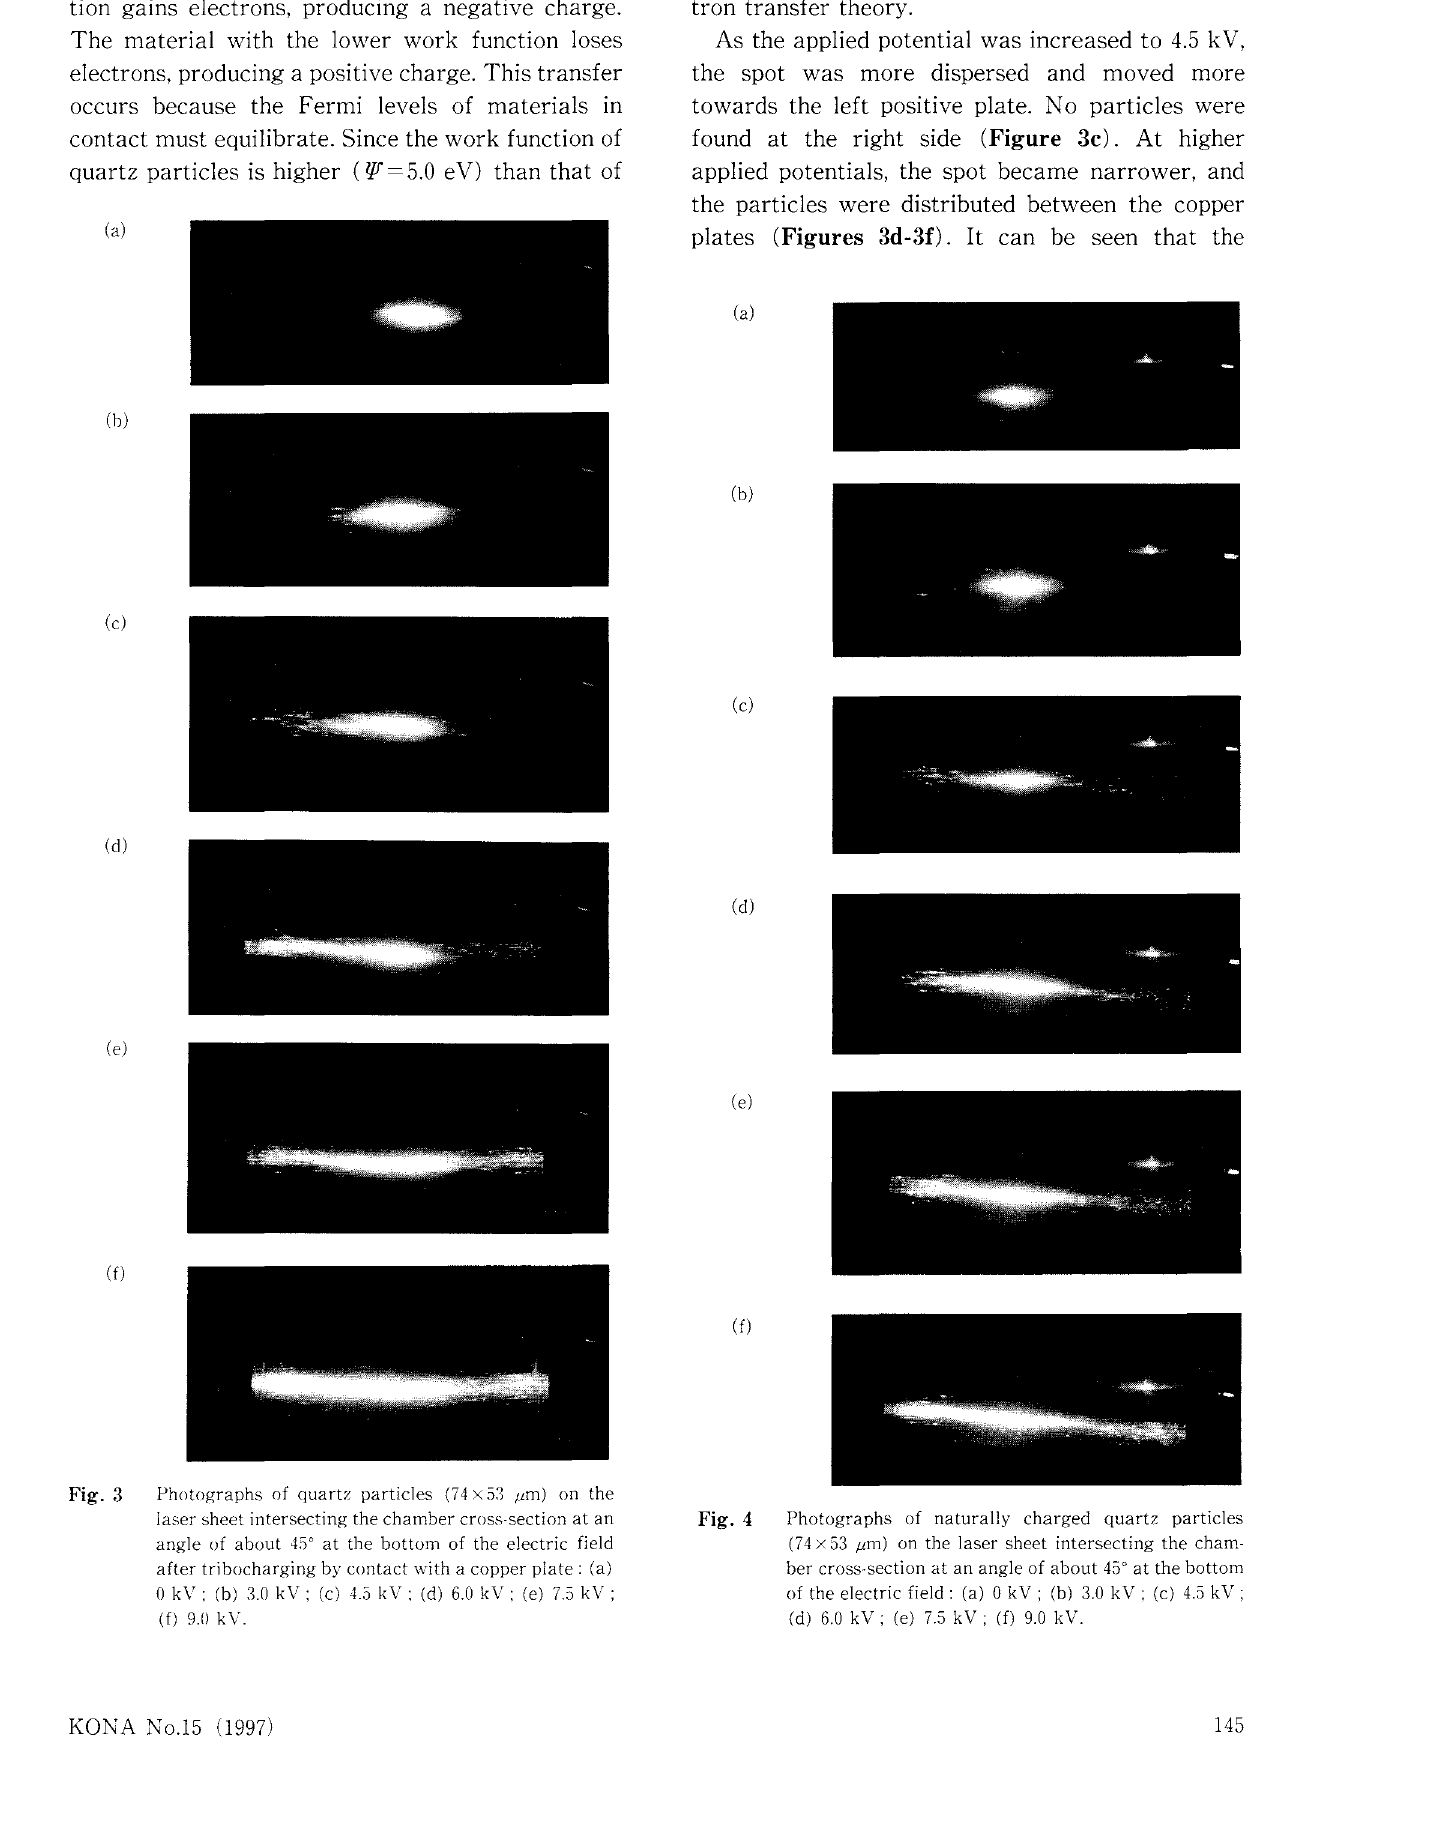
Fig. 3 Photographs of quartz particles (74 x5:l 11m) on the laser sheet intersecting the chamber cross-section at an angle of about 45° at the bottom of the electric field after tribocharging by contact with a copper plate: (a) 0 k\'; (b) 3.0 kV; (c) 4.5 k\'; (d) 6.0 k\'; (e) 7.5 k\'; (f) 9.11 k\'.